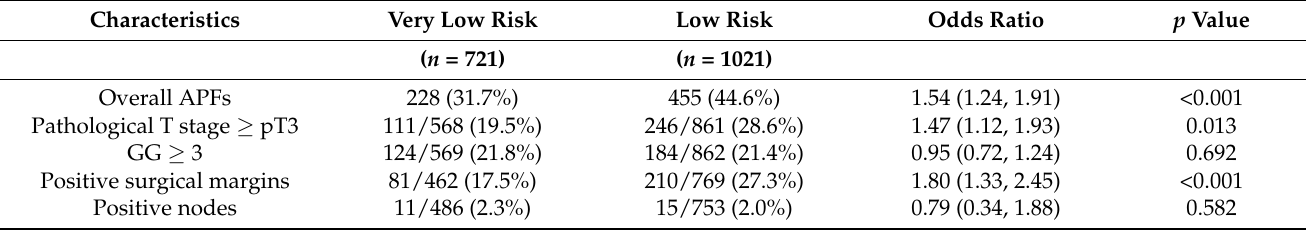
Table 2. Comparison of adverse pathological features between very low risk and low risk sub-group.